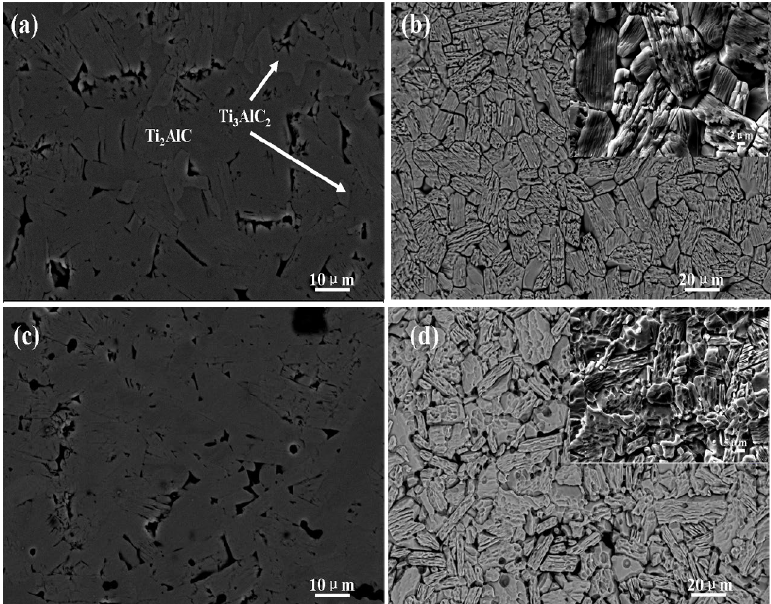
Fig. 3 SEM microstructures of (a, b) Ti 2 AlC and (c, d) Ti 2 AlSn 0.2 C. The observed grain surfaces of bulks were polished and etched by the HF and HNO 3 mixed